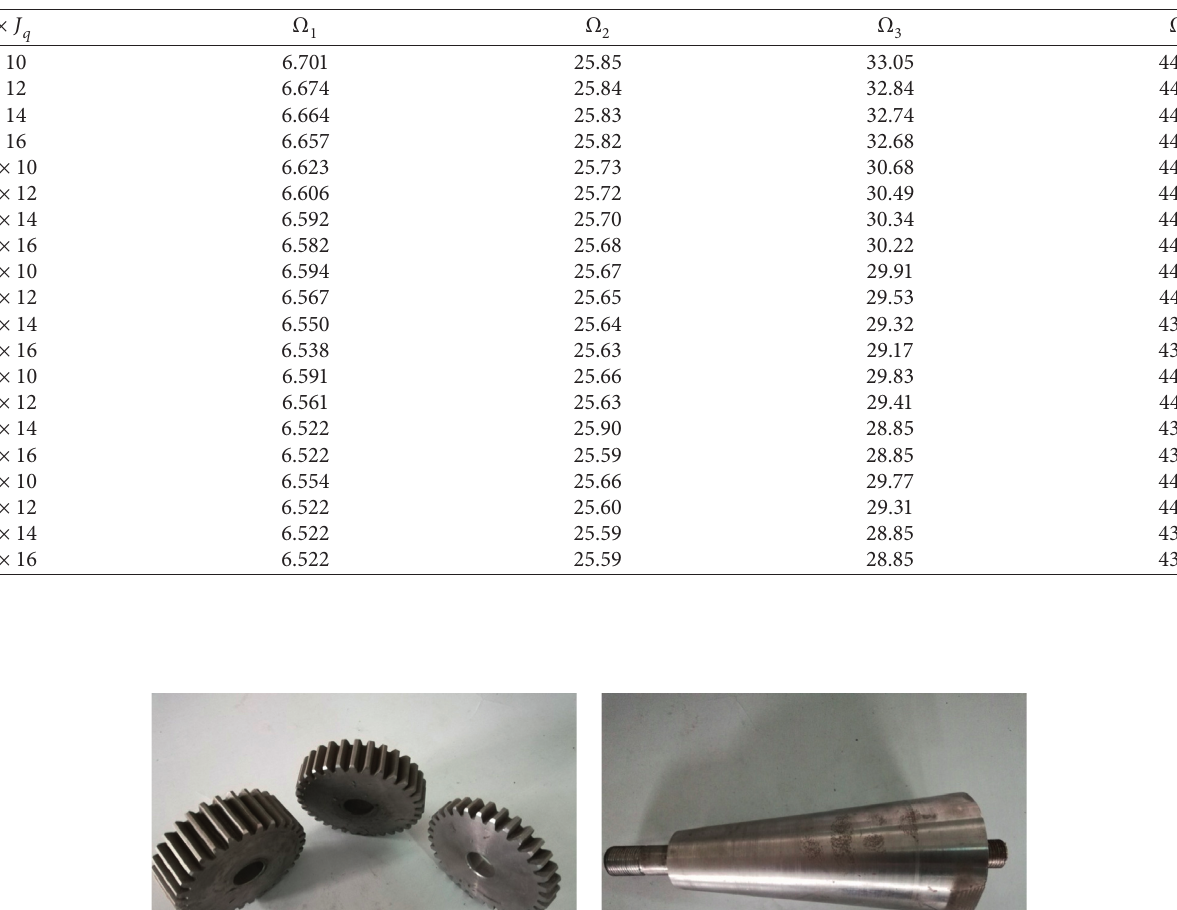
Table 1: Convergence of the first four eigenvalues in Ω � ω